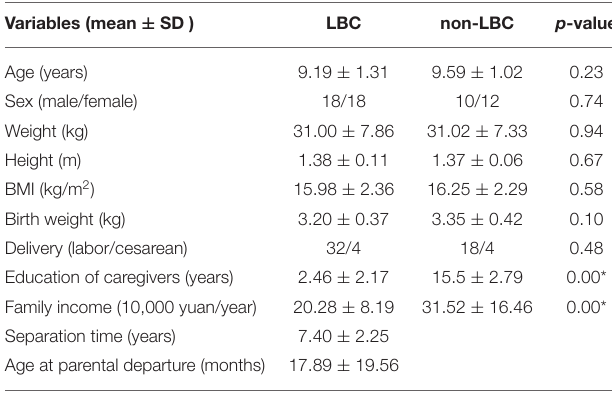
TABLE 1 | Demographic information of left-behind children (LBC) and healthy controls (HC).